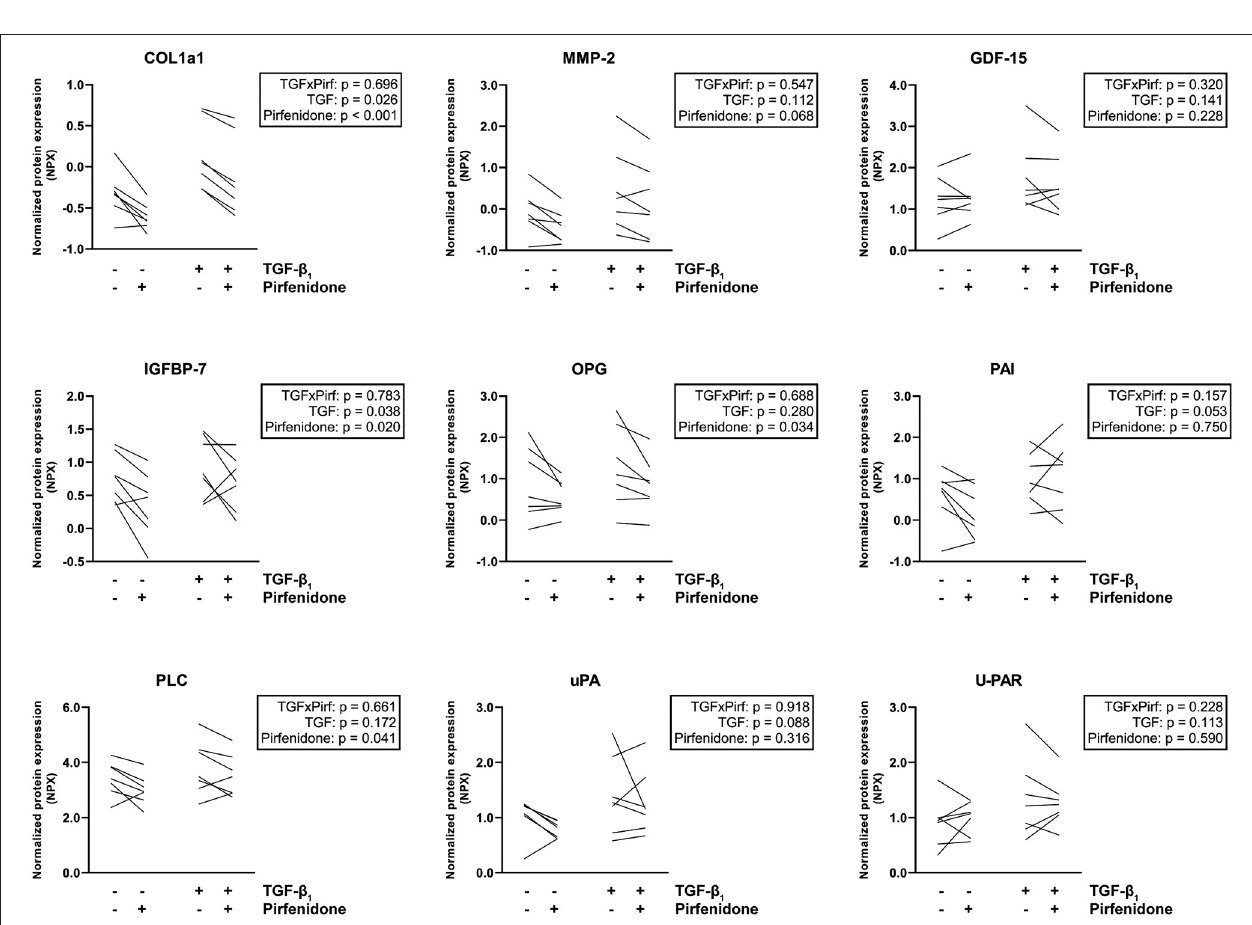
FIGURE 5 | Targeted proteomics reveals that pirfenidone does not undo all TGF- β 1-induced pro-fibrotic effects. Pirfenidone causes a decrease in COL1a1 expression in both fibrotic and control conditions. In other fibrosis and heart failure related proteins, different effects can be seen. Data are represented as mean normalized protein expression (compared to internal control) per experiment ( n = 7). Statistical analysis was performed using repeated measures two-way ANOVA. The interaction effect and the main effects are reported in the statistical box on the right side of the graph.